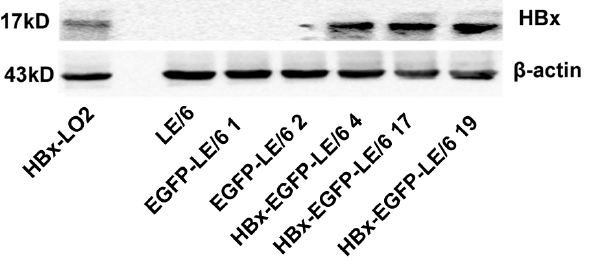
19 strongly expressed HBx protein. Non-transfected LE/6 and mock-transfected